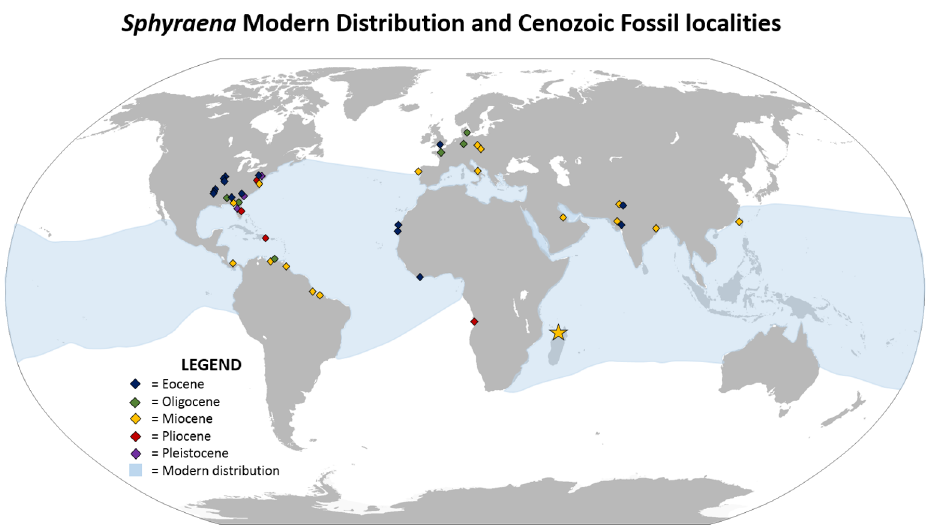
Fig 4. Recent distribution of barracudas (shown in light blue) and sites where fossil Sphyraena have been recovered.Yellow star indicates Nosy Makambysite. Some fossil distributional data obtainedfrom Paleobiology